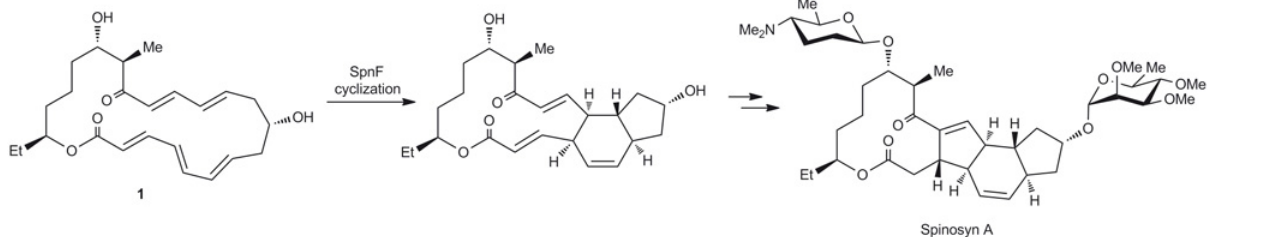
Fig 1. SpnF-mediated cyclization. SpnF-mediated cyclization leading to cyclohexene ring in the biosynthesis of Spinosyn A.